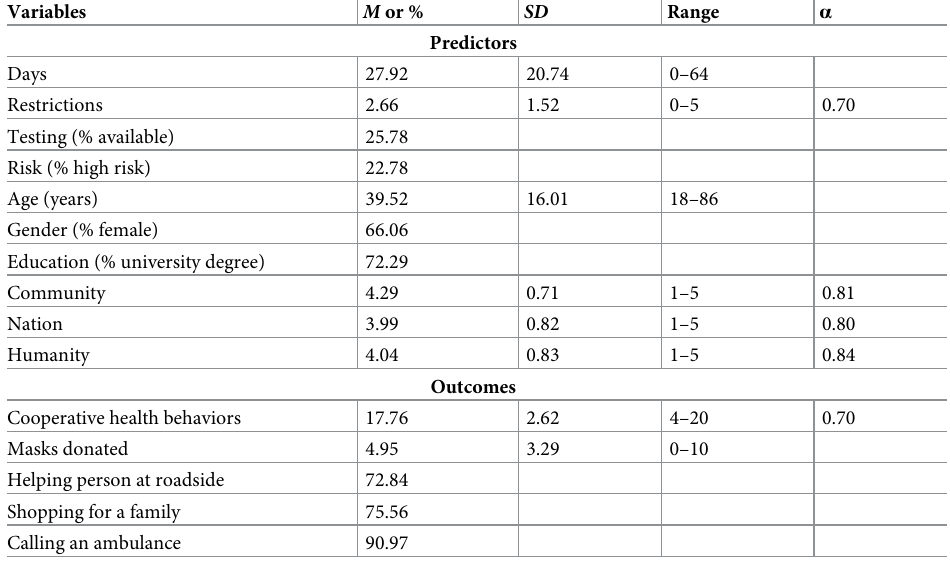
Table 1. Descriptive statistics for predictor and outcome variables, including Cronbach’s alpha for scale scores ( N = 2537).